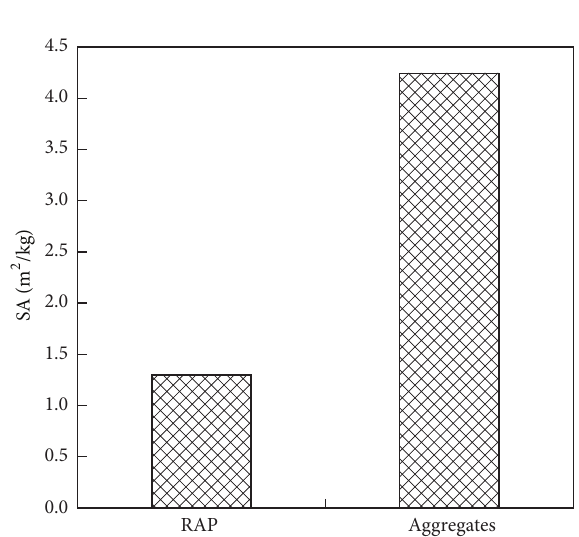
Figure 2: SA of RAP and aggregates.